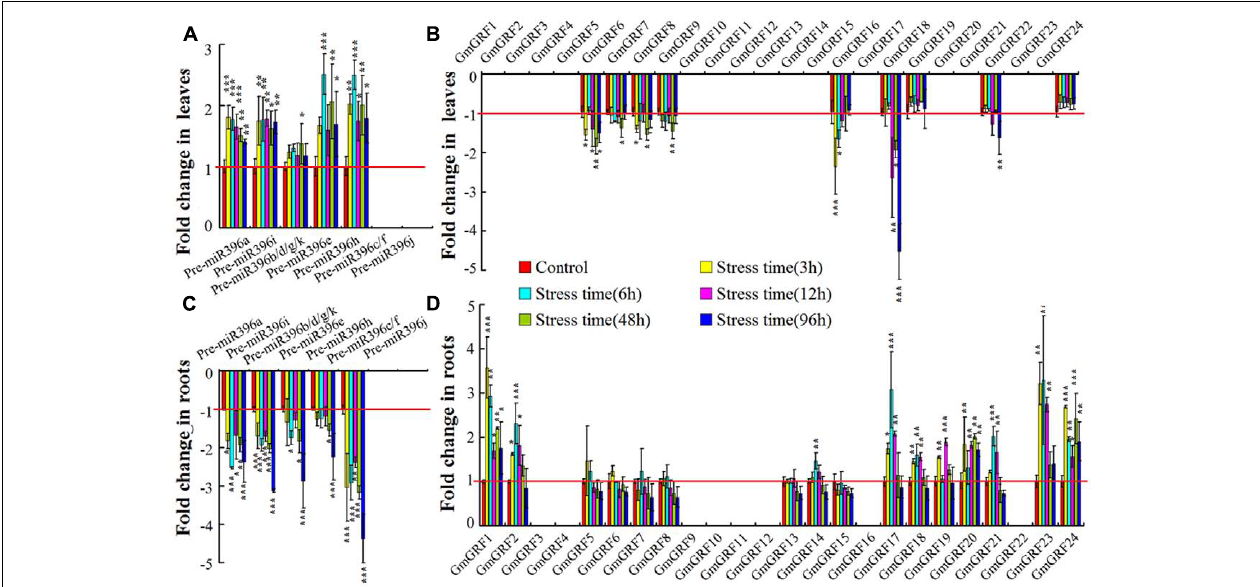
FIGURE 1 | Low water potential stress induced tissue-specific expression of miR396– GRF module. (A,B) Expression analysis of gma-miR396 precursors in leaves and roots of low water potential stressed soybean. Expression of each gma-miR396 precursor in soybean cultured under normal conditions served as control. (C,D) Expression analysis of 24 predicted target GmGRF gene s of gma-miR396 in leaves and roots of low water potential stressed soybean. Expression of each GmGRF gene in soybean cultured under normal conditions served as control. In all panels, values are average of three biological replicates ± SD, different asterisks indicate significant difference applying ANOVA ( ∗ P < 0.05; ∗∗ P < 0.01; ∗∗∗ P < 0.001). Universal primers were used for expression analysis of Pre-miR396b/d/g/k because of their sequence homology. Because of large deviations in some micro-expression genes data, they were excluded from